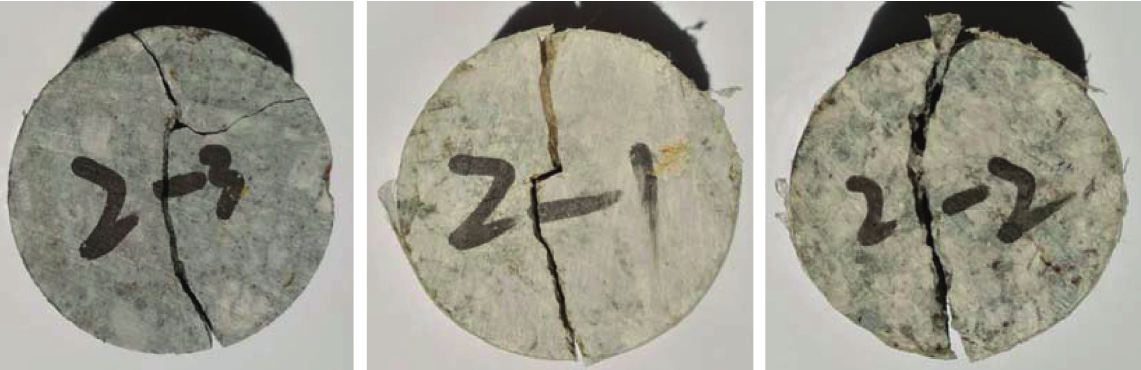
Figure 4: Brazil disk split test with granite specimens.